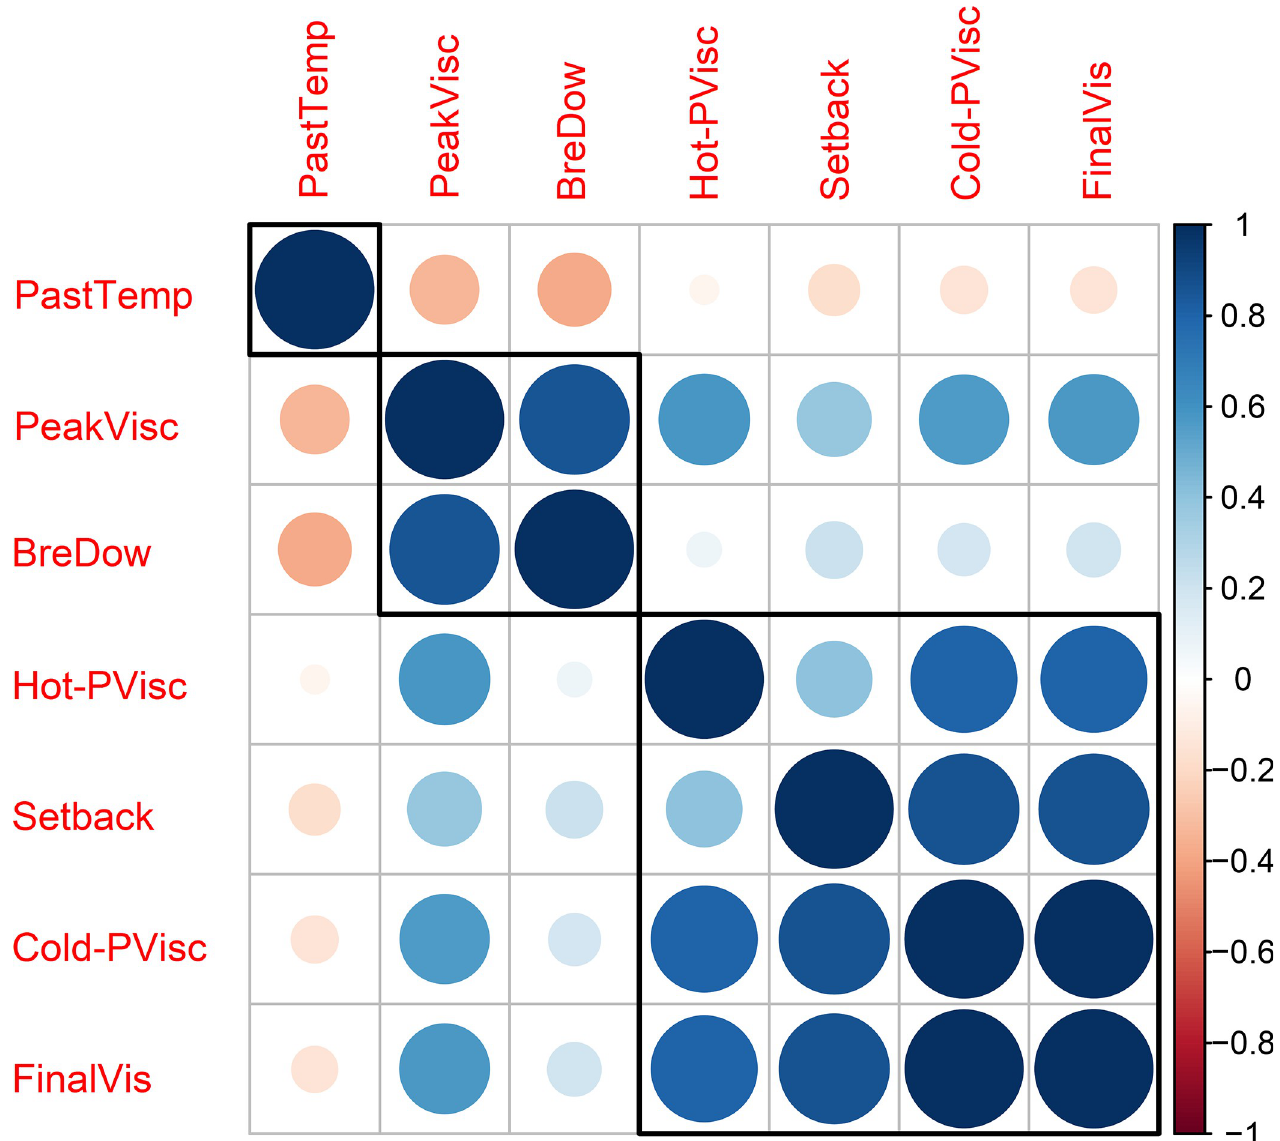
Fig 1. Correlogram of the pasting property traits of cassava starch from 876 accessions. Positive correlations are displayed as blue circles and negative correlations as orange circles. The sizes of the circles are proportional to the correlation coefficients. https://doi.org/10.1371/journal.pone.0262888.g001 PLOS ONE | https://doi.org/10.1371/journal.pone.0262888 January 21,